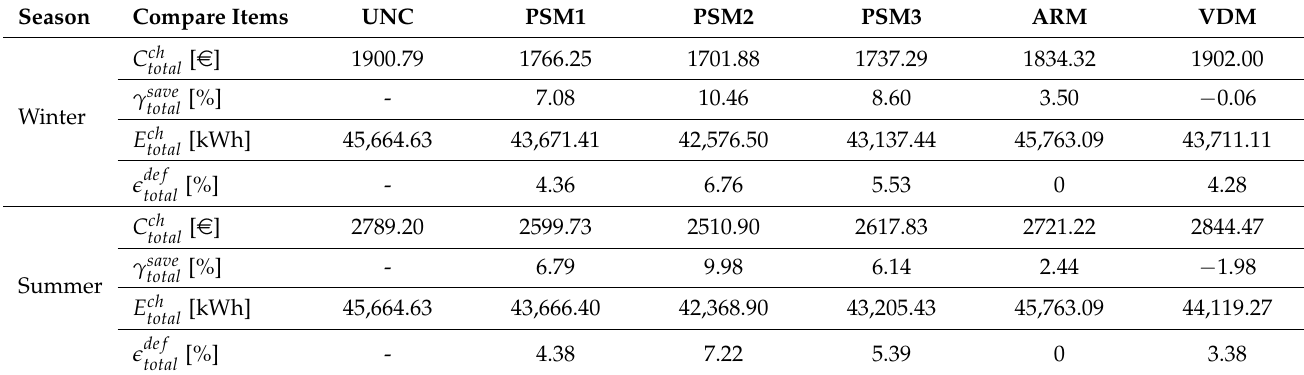
Table 3. Total charging cost and energy failed to deliver